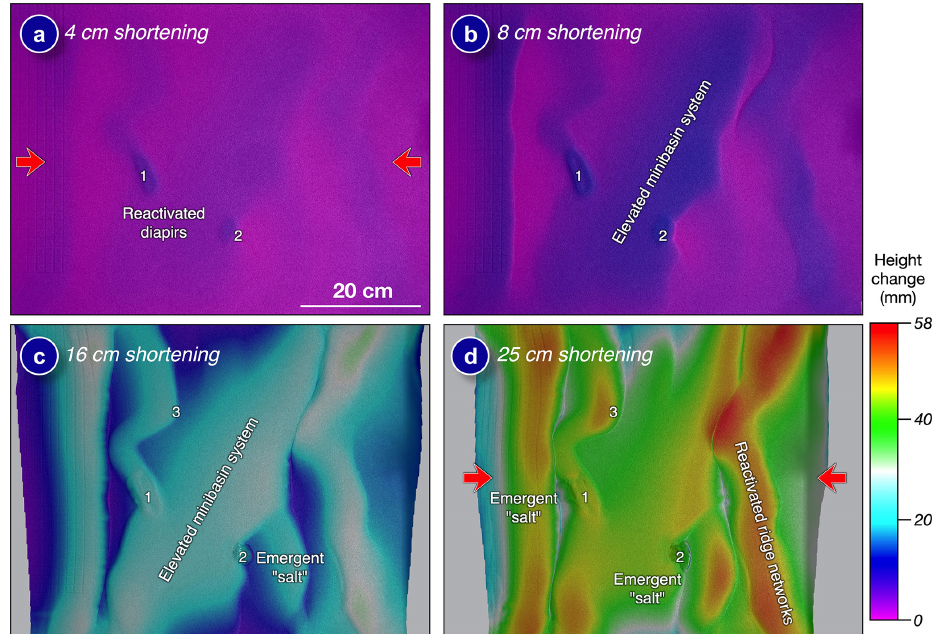
Figure 7. Height-change maps (a–d) reveal the evolution of Model 1 during inversion. The initial shortening and uplift process was focused on the diapirs formed during extension and loading (a) , followed by uplift of the composite minibasin above the model center and rejuvenation of the diapir and ridge networks (b–d) .